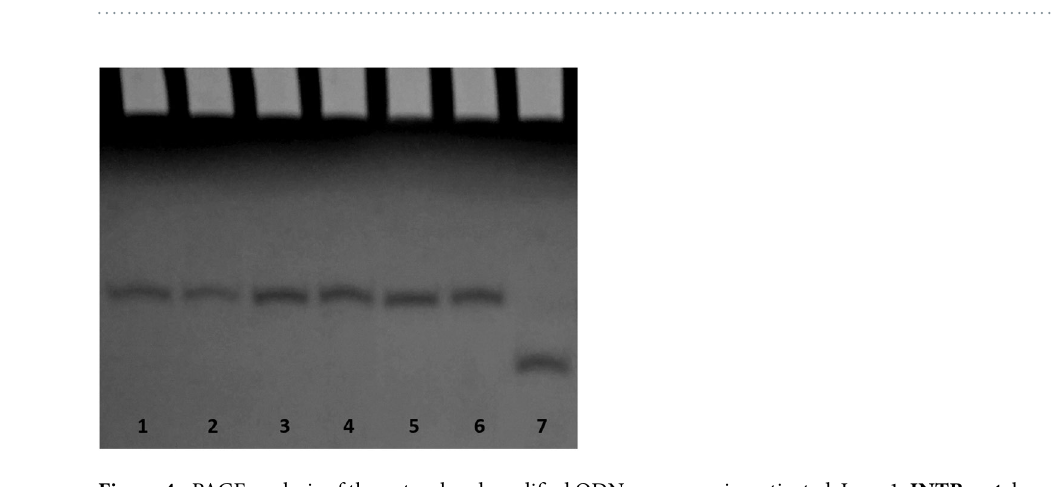
of the imino proton regions diagnostic of the presence of G-quadruplex structures (10.5–12.0 ppm) strongly sug- gests that the G-quadruplex structures adopted by the modified ODNs containing an H residue strictly resemble